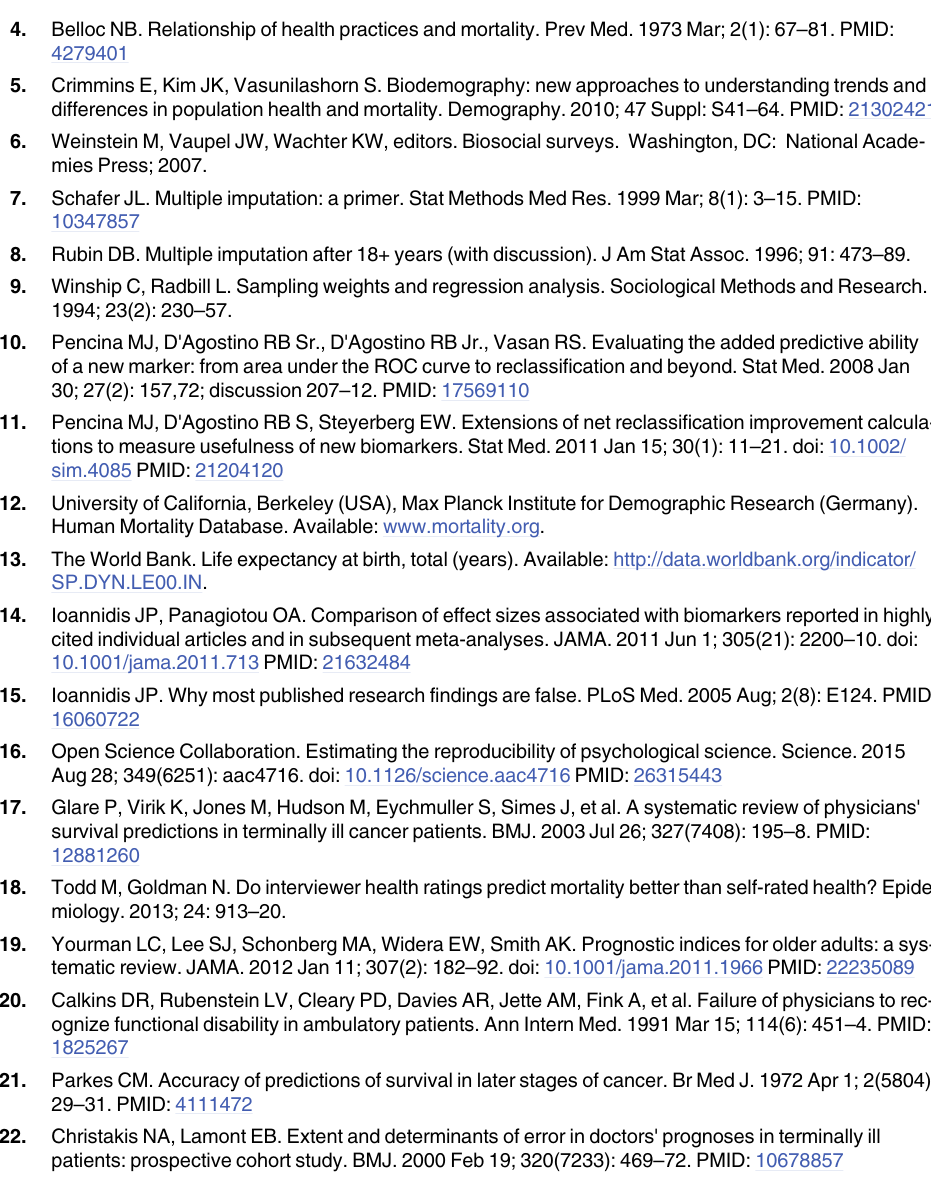
PLOS ONE | DOI:10.1371/journal.pone.0159273 July 19,